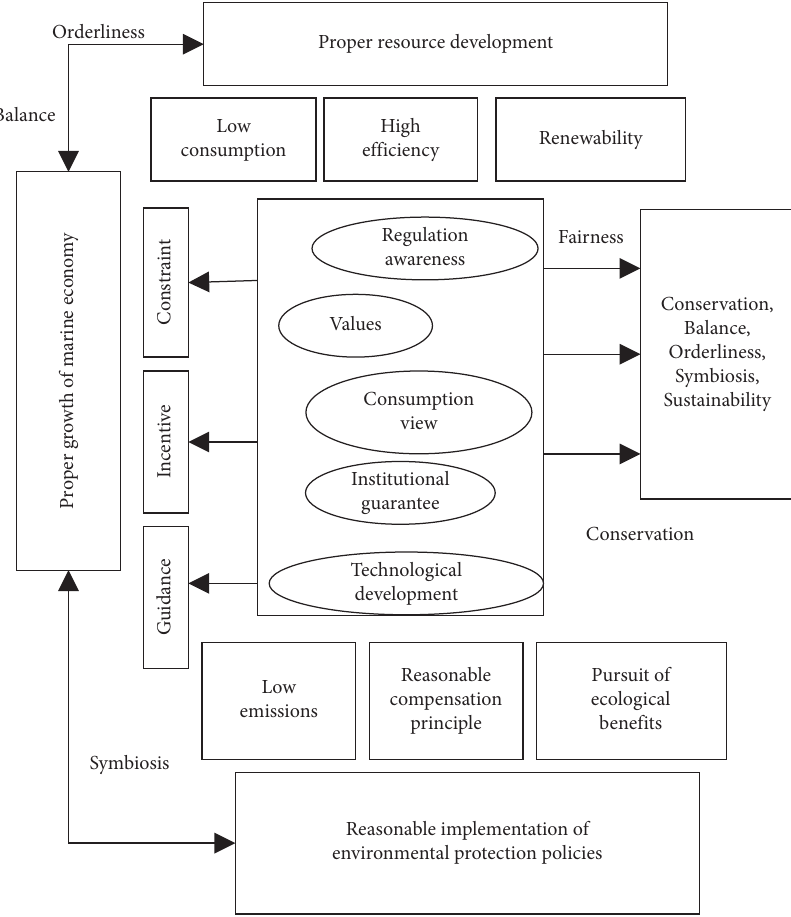
Figure 1: Ecology-dominated coordinated development model for the complex system.